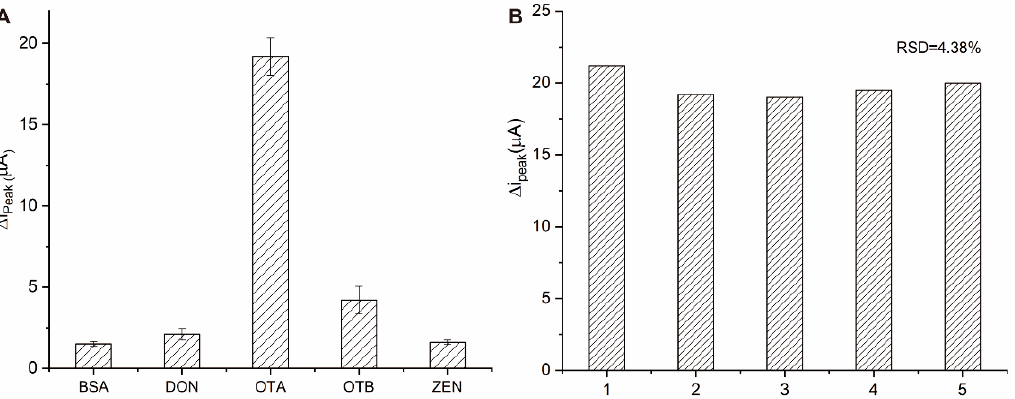
Figure 6. ( A ) The specificity of the proposed aptasensor against OTA, OTB, BSA, ZEN, and DON; ( B ) The reproducibility of five different electrodes.